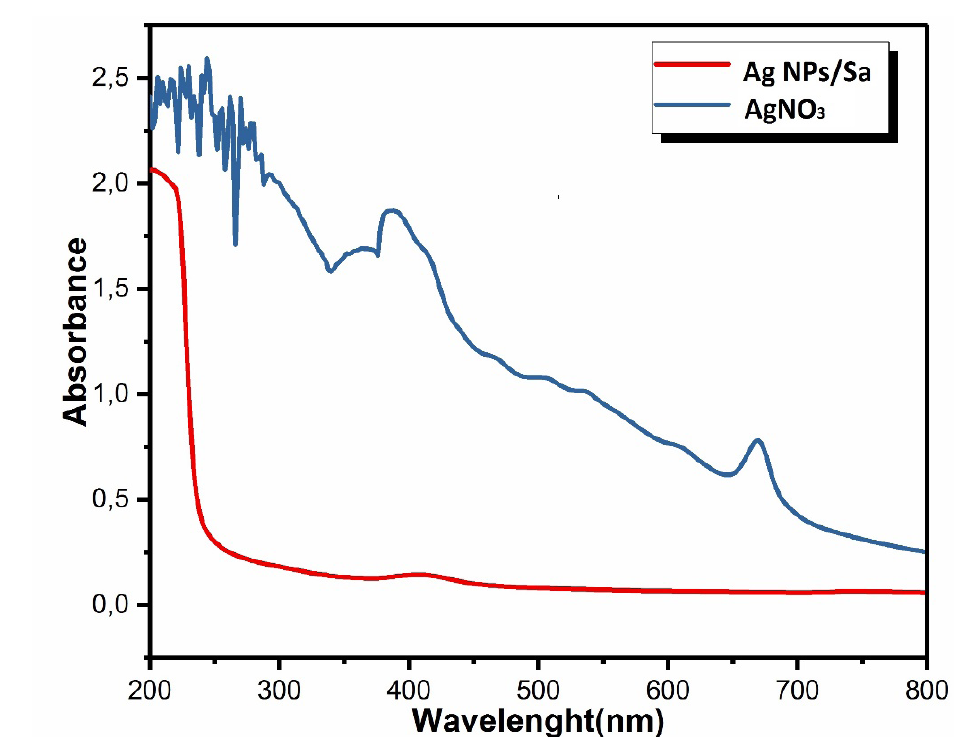
FIGURE 4 - UV-vis spectra of AgNO